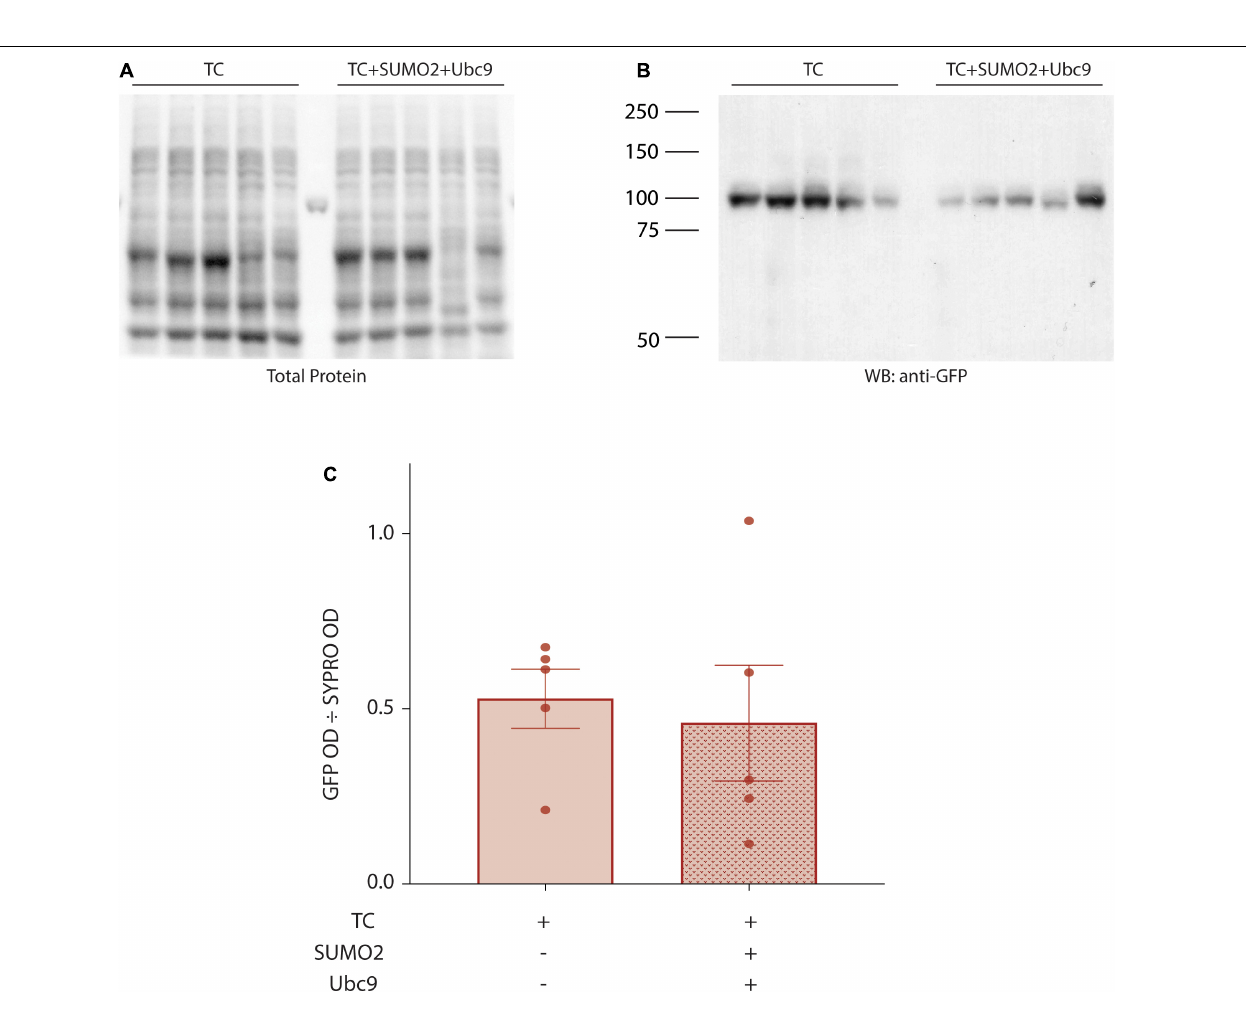
FIGURE 4 | Kv4.2g steady-state levels are not altered by enhancing SUMOylation. Lysates (10 µ g) from HEK cells expressing Kv4.2g+ HA-KChIP2a+ HA-DPP10c with (+) or without (–) SUMO2 + Ubc9 were resolved with PAGE and transferred to a PVDF membrane. Total protein was visualized with SYPRO Ruby blot stain. Afterward, the same membrane was probed with anti-GFP to visualize Kv4.2g. Kv4.2g protein expression was quantified by dividing the OD for the Kv4.2g signal by the OD for the total protein signal in the entire lane. Western blot showing (A) SYPRO Ruby total protein staining and (B) Kv4.2g signal. Each lane represents one independent experiment. The source of the variability between experiments is not known. Note that the single band in the lane between TC and TC + SUMO + Ubc9 on the SYPRO Ruby stained blot is one rung on the pre-stained molecular weight ladder. (C) Bar graph showing mean ± SEM Kv4.2g protein expression. Each data point represents one independent experiment. TC, 0.53 ± 0.19 vs. TC + SUMO2 + Ubc9, 0.46 ± 0.37; t -test p =